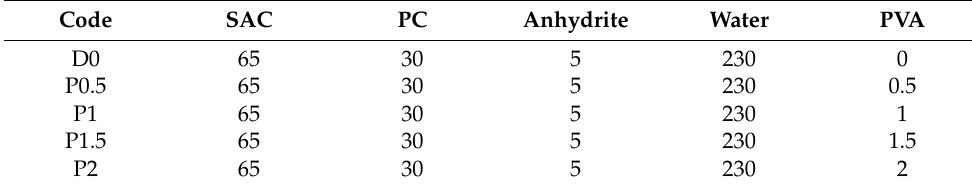
Table 2. Mix proportions of composite